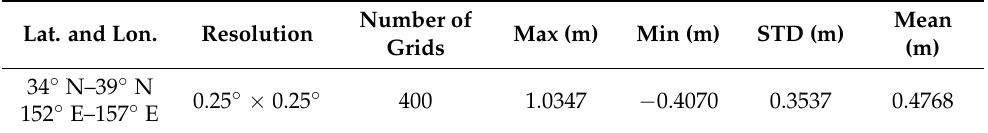
Figure 4. Annual range of the global sea level anomalies in 2020 (unit: m).